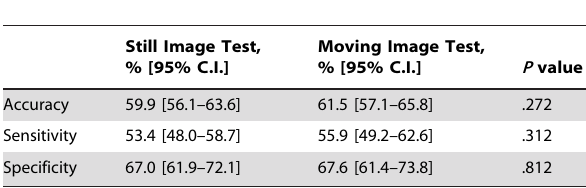
Table 3. Diagnostic Accuracy, Sensitivity, and Specificity of Cancerous versus Noncancerous Lesions of Still Image Test versus Moving Image Test in Overall 34